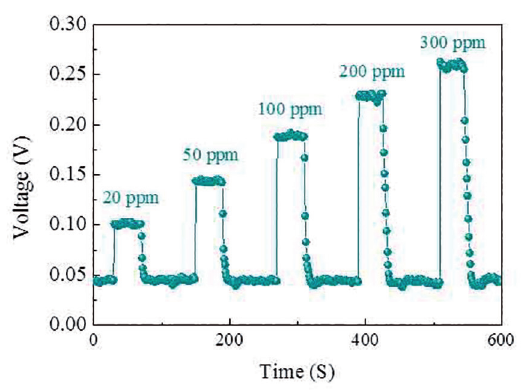
Figure 5: Response-recovery curves of the PbS sensors to different ethanol